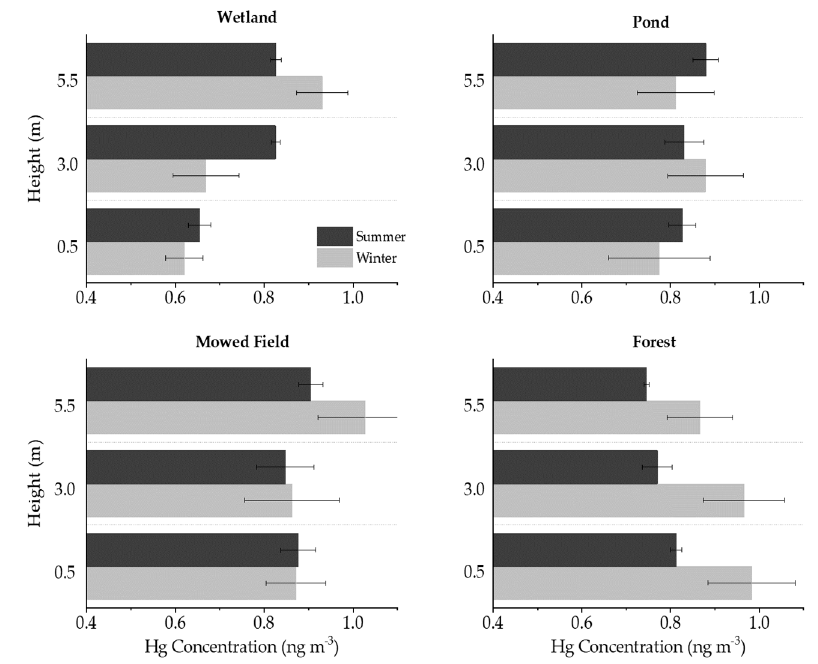
Figure 4. Mean concentrations (ng m − 3 ± 1 S.E.) of gaseous elemental mercury determined with passive air samplers deployed at four adjacent landscapes in north-central Mississippi.